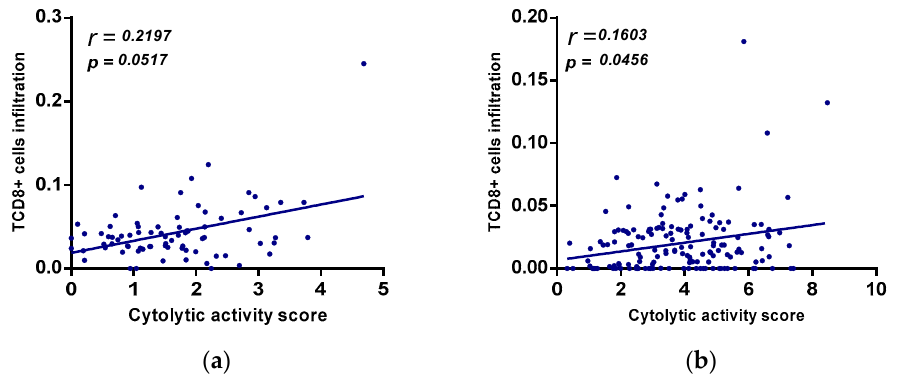
Figure 8. Correlation of A 2A R expression with lymphocyte exhaustion genes. ( a ) The CGGA male cohort; ( b ) The TGGA astrocytoma cohort. The more intense the red color, the stronger the gene expression; Green/orange color: Low A 2A R/High A 2A R.